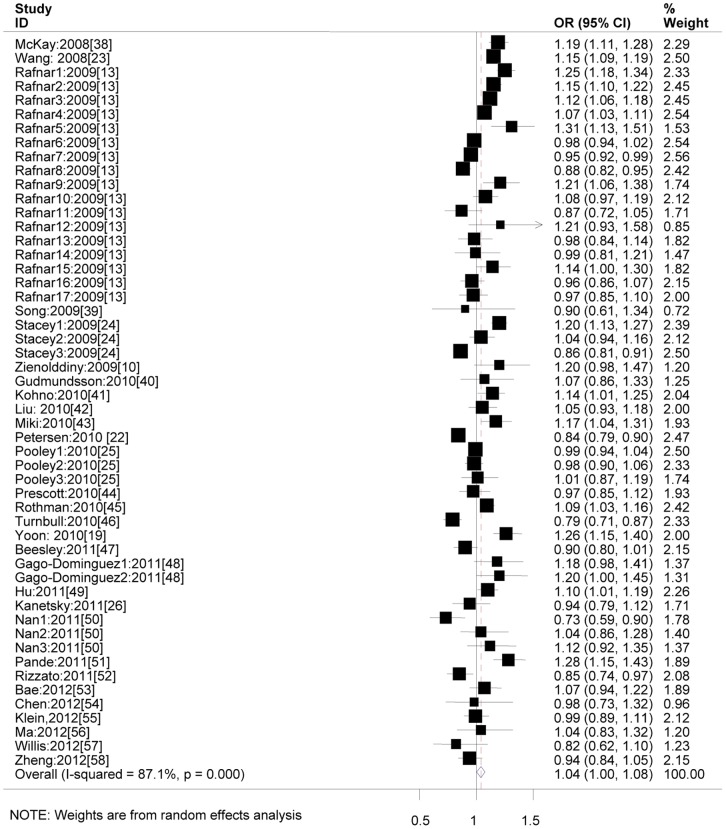
ORs of overall cancer risks associated with rs401681 under the additive model by random effects.For each data set, the OR and 95% CI was plotted with a box and a horizontal line. The symbol filled diamond indicates pooled OR and its 95% CI. Stacey1-3 represented studies for cancers of basal cell, squamous cell carcinomas and melanoma, respectively; Rafnar1-17 represented studies for basal cell, lung, bladder, prostate, cervical, breast, colorectal, melanoma, endometrial, kidney, lymphoma, multiple myeloma, ovarian, pancreatic, squamous cell, stomach and thyroid, respectively; Gago-Dominguez1-2 represented studies for bladder cancer in Caucasians and Asians, respectively; Pooley1-3 represented studies for breast, colorectal cancers and melanoma, respectively; Nan1-3 represented studies for melanoma, squamous cell and basal cell carcinomas, respectively.